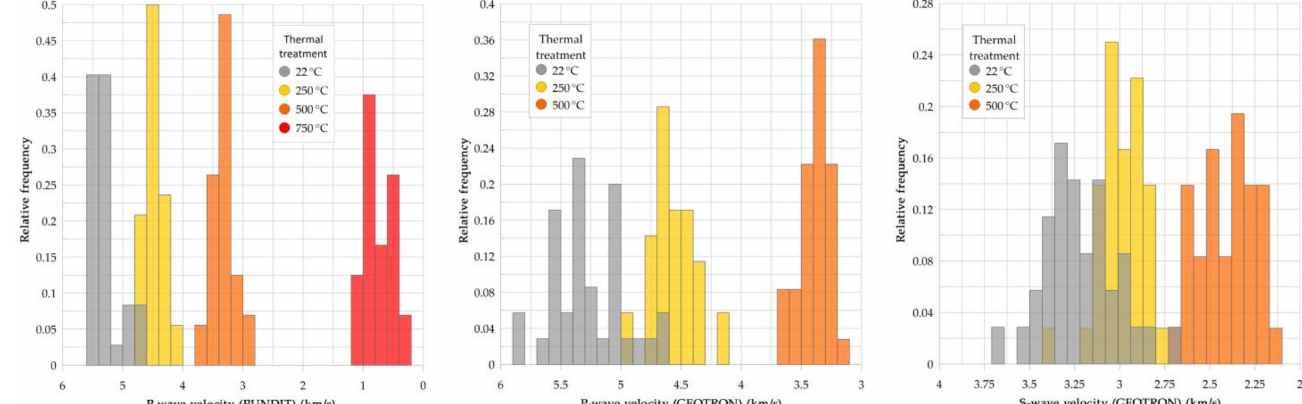
Figure 11. Relative frequency histograms of measured ultrasound velocity properties among heat-treated groups: Histogram of P-wave velocity (PUNDIT device) values ( left ). Histogram of P-wave velocity (GEOTRON device) values ( middle ). Histogram of S-wave velocity (GEOTRON device) values ( right